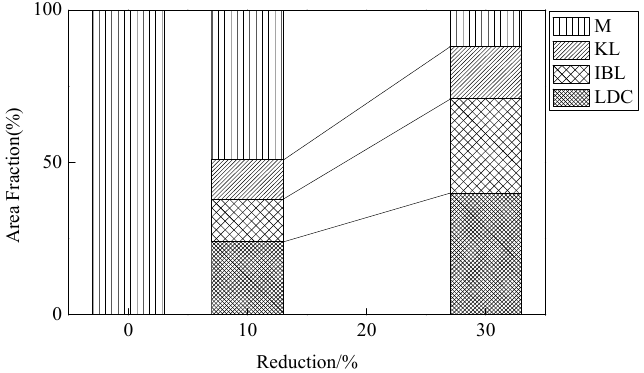
Figure 5. Fraction of the areas showing lamellar dislocation cells (LDCs), irregularly bent lath (IBL), kinked lath (KL), and lath martensite (M) in the sheets cold rolled to a reduction of 10% and 30%. The initial microstructure was martensite.